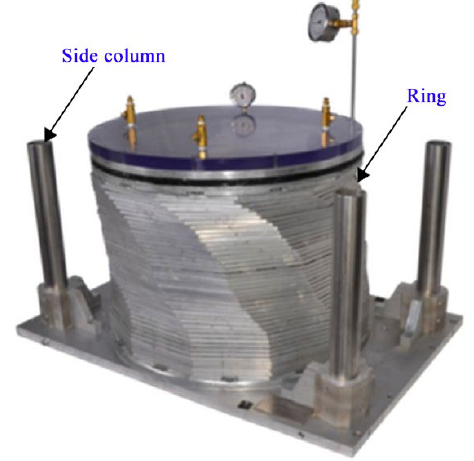
Figure 11. Laminar box system (From Thevanayagam et al. [57]; modified).